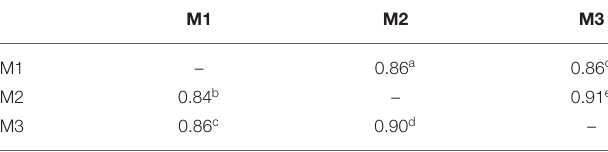
TABLE 8 | Retest-reliability of the TPA scales.